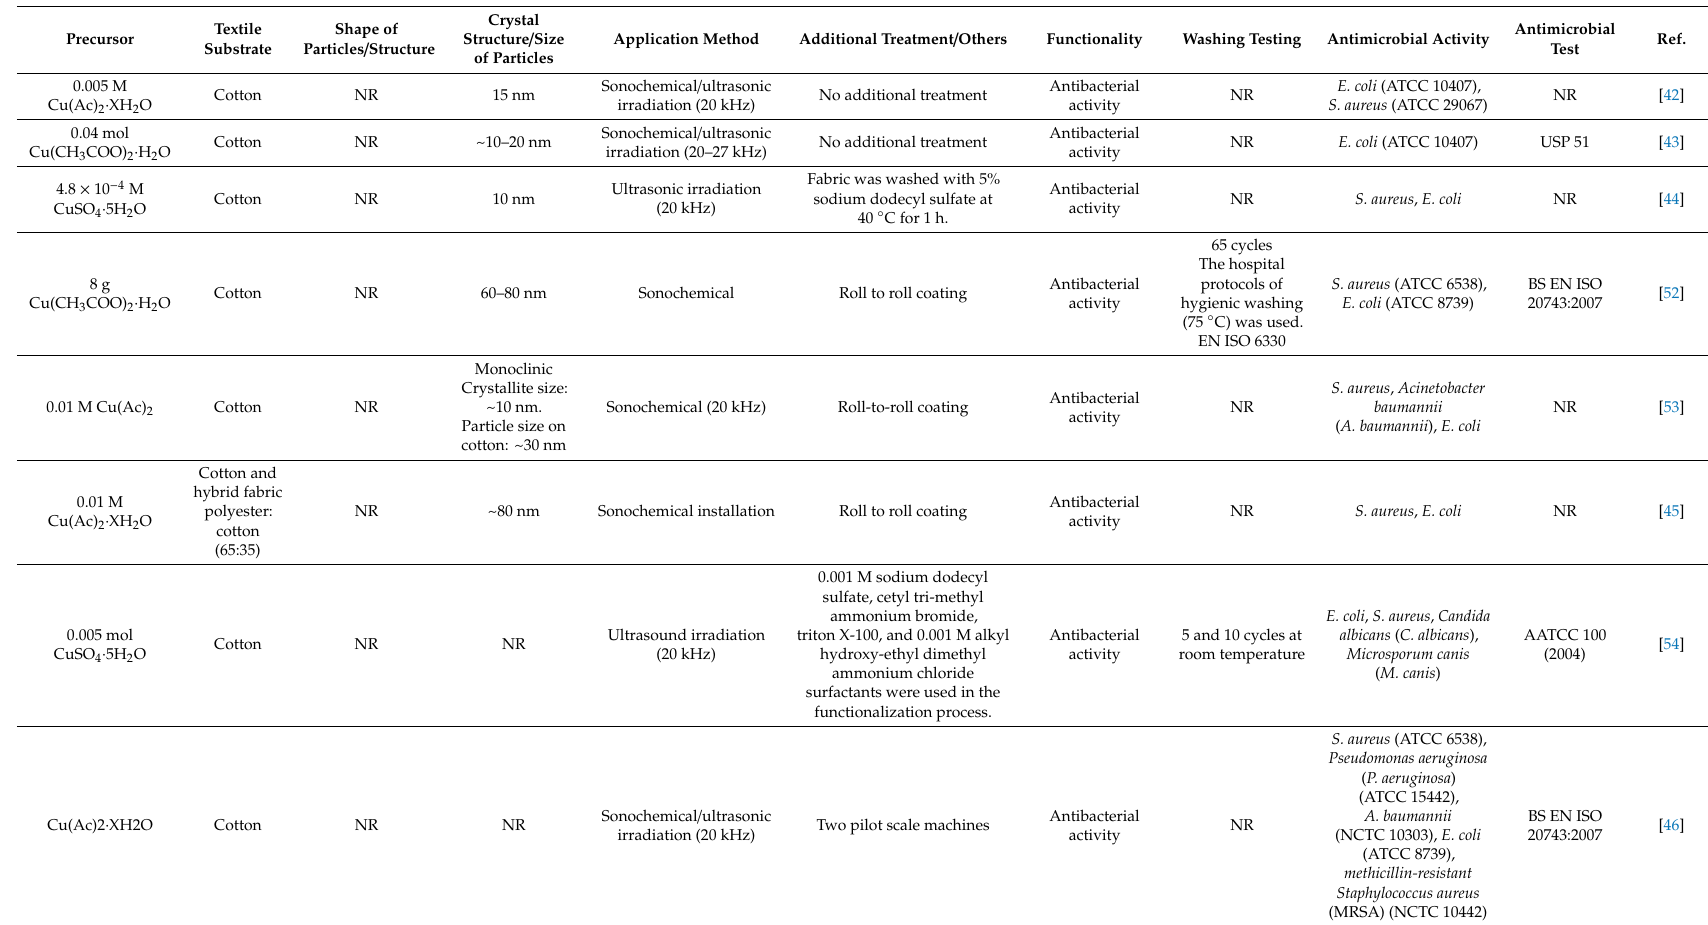
Table 1. Summary of the functionalization of textile materials with CuO NPs conducted by the in situ